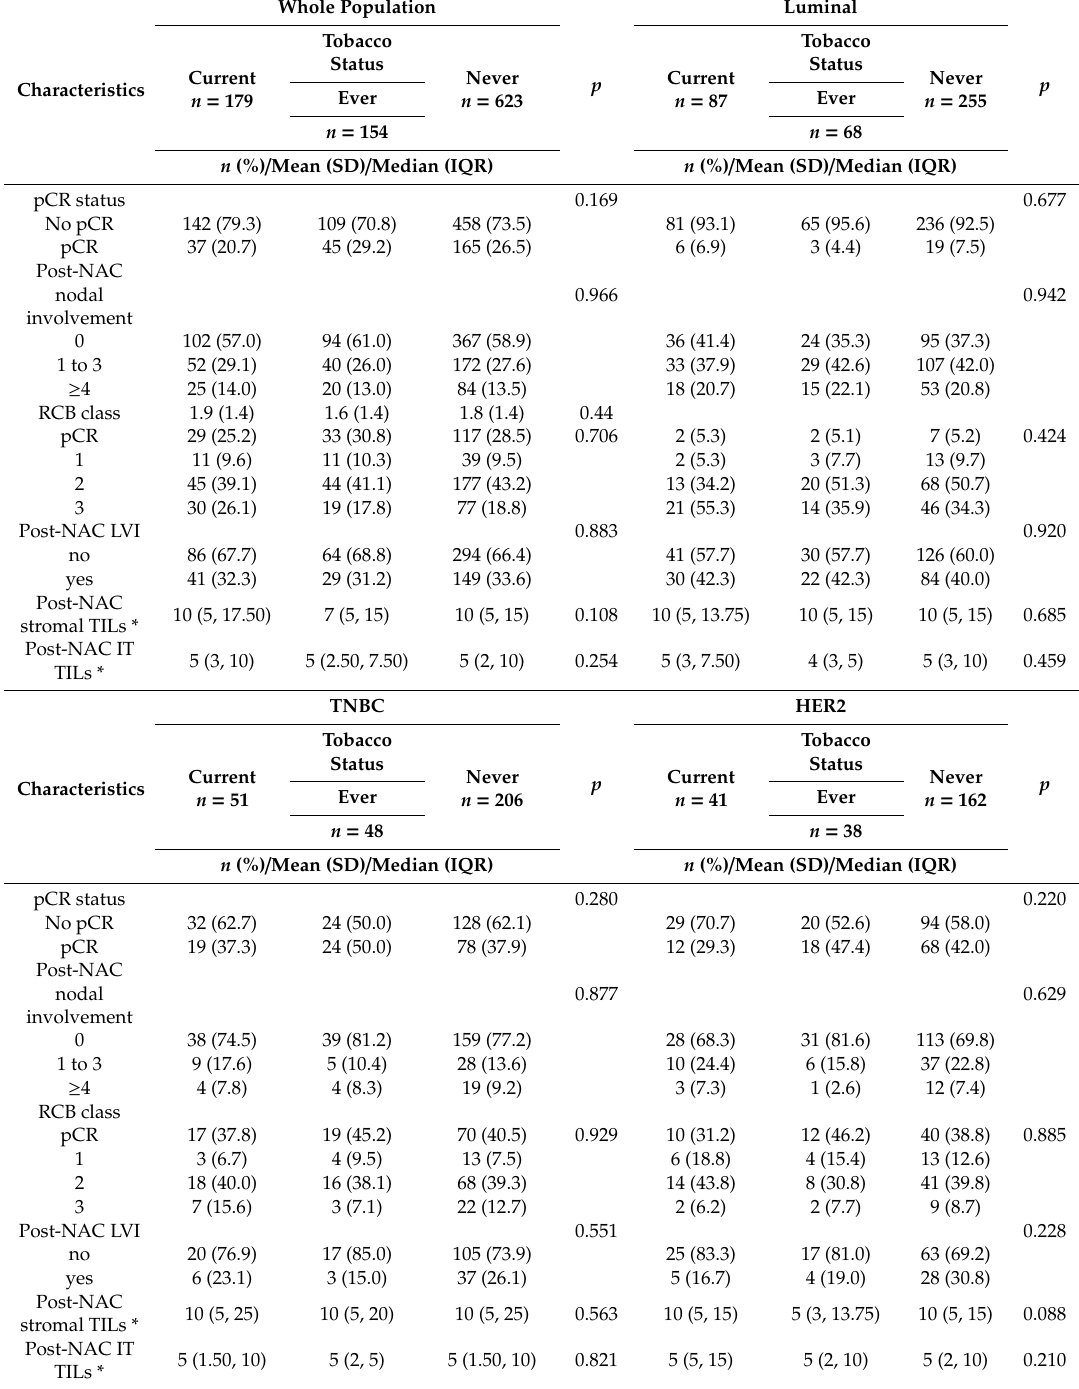
Table 2. Post-NAC TILs, pCR and RCB class according to smoking